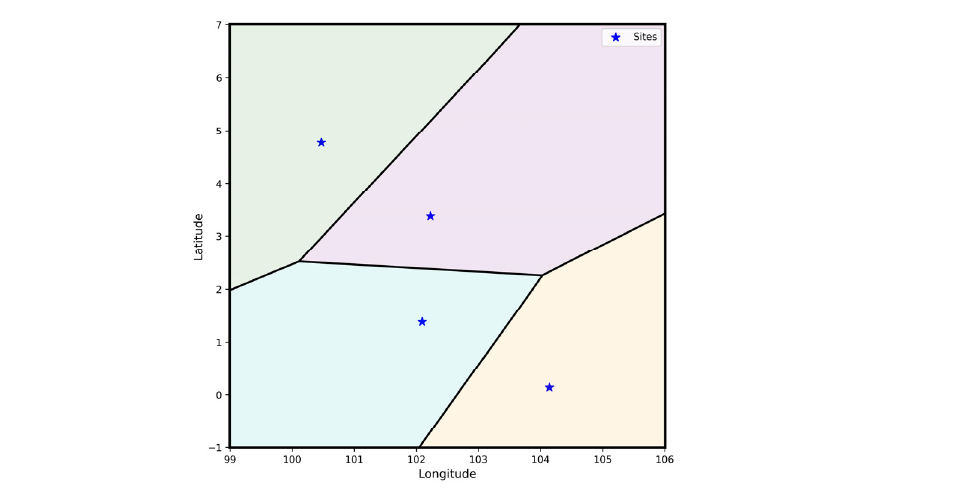
Table 1. The subjective weight of each factor of dynamic